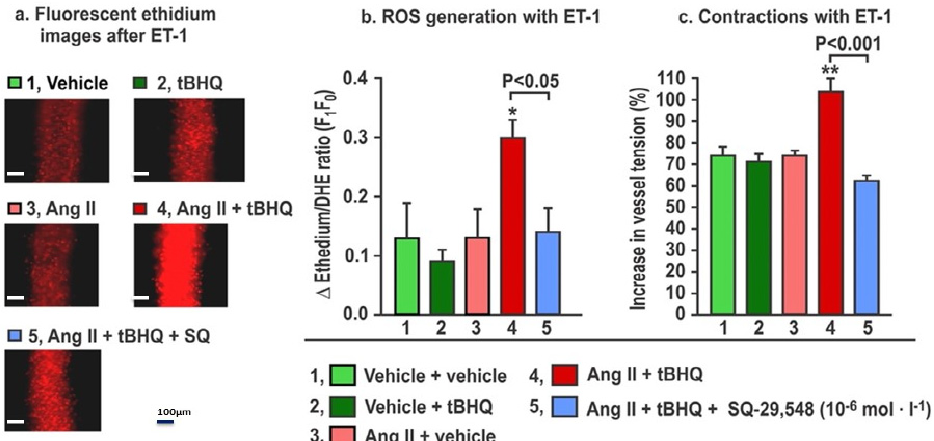
Figure 5. The increases in reactive oxygen species (ROS) generation and contractions with endothelin- 1 in mesenteric microarterioles from mice given tBHQ (0.1% × 3 days) vs. vehicle and infused with angiotensin II (400 ng · kg − 1 · d − 1 SC × 3 days) vs. sham have increased reactive oxygen species (Panels a and b ) and contractions to endothelin 1 (Panel c ) that are prevented by incubation for 30 min with SQ-29,584 (10 − 5 mol · L − 1 ) to block thromboxane prostanoid receptors. Fluorescent microscopy images of ethidium fluorescence (Panel a ) and mean ± SEM values for ROS generation (Panel b ) and contractions (Panel c ) with endothelin 1 (ET1, 10 − 7 mol · L − 1 ) in mesenteric microarterioles from mice (n =